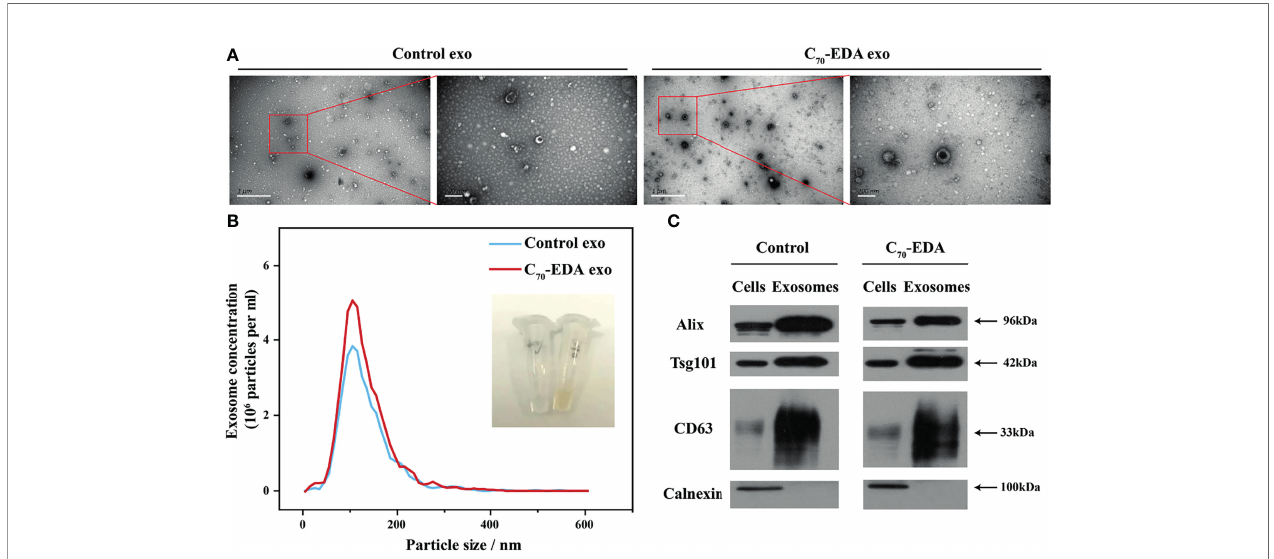
FIGURE 2 | Characterization of exosomes secreted by THP-1 cells treated with C 70 -EDA (20 m M). (A) TEM images of the exosomes. Scale bars are 1 m m (left) and 200 nm (right). (B) Hydrodynamic diameter distribution and optical image of the exosomes. (C) Expression of speci fi c markers (Alix, TSG101, CD63, and calnexin) in the exosomes. Alix, apoptosis-linked gene-2-interacting protein X; TSG101, tumor susceptibility gene